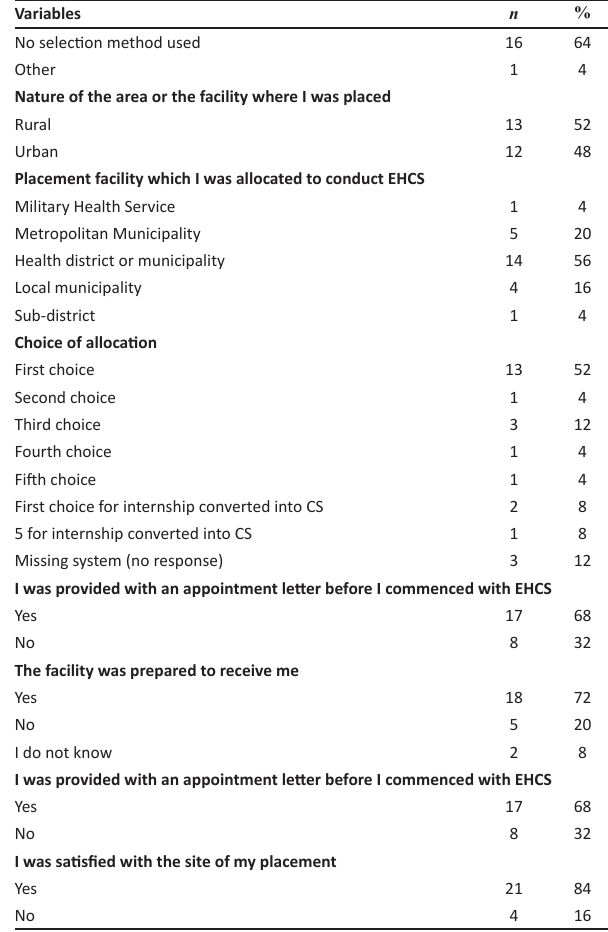
TABLE 1: Environmental Health Community Service administrators’ and practitioners’ experiences relating to the selection and placement